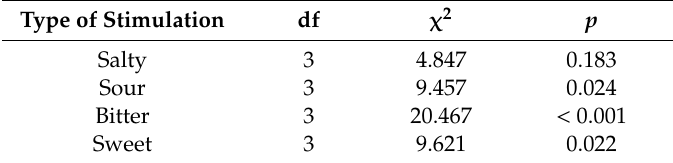
Table 5. Evaluation of taste function according to concentration of the tastant